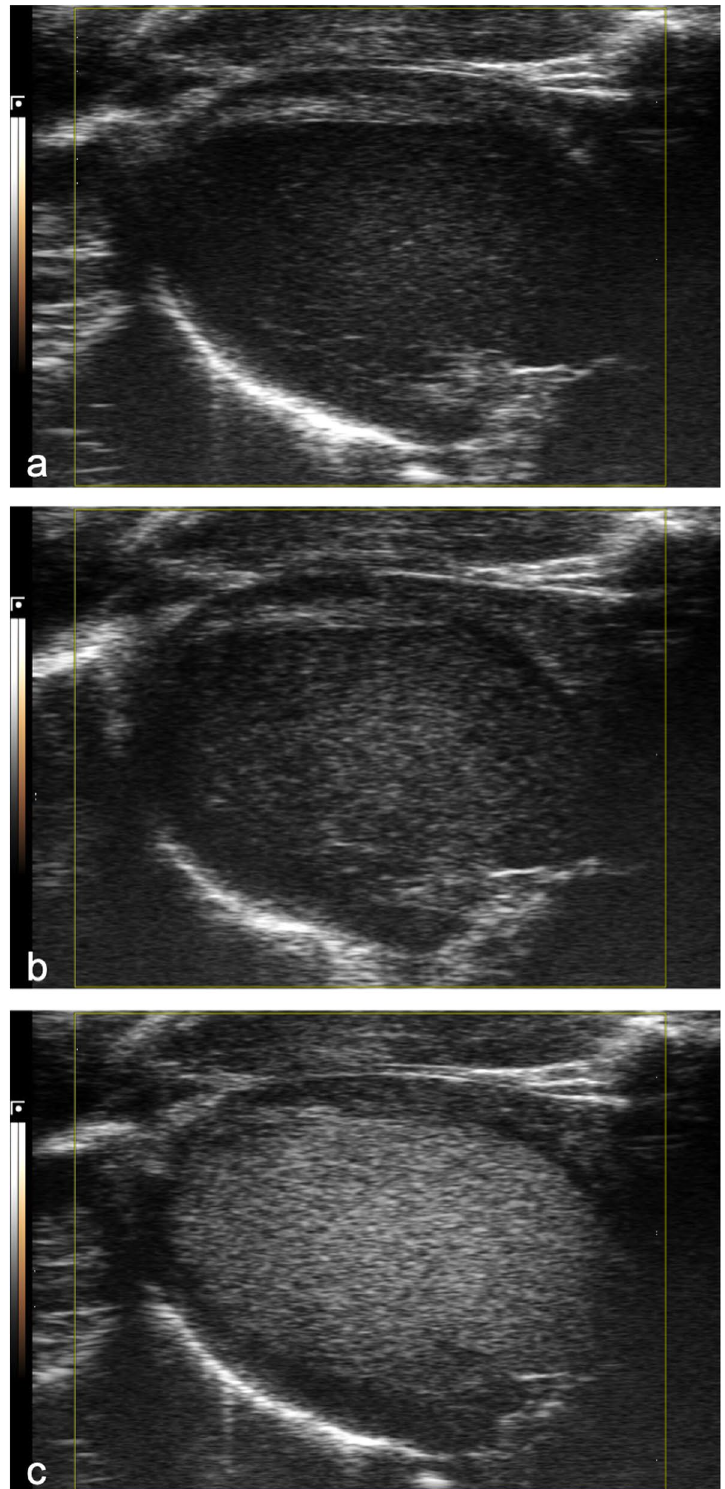
Fig. 4 Representative time course of contrast activity in the lumen of the left ventricle. Shown are systolic gated modified parasternal long axis images that were acquired during nonlinear contrast imaging at the time of contrast agent arrival, i.e. , 0 s ( a ), 1 s ( b ), and 10 s ( c ) after contrast agent